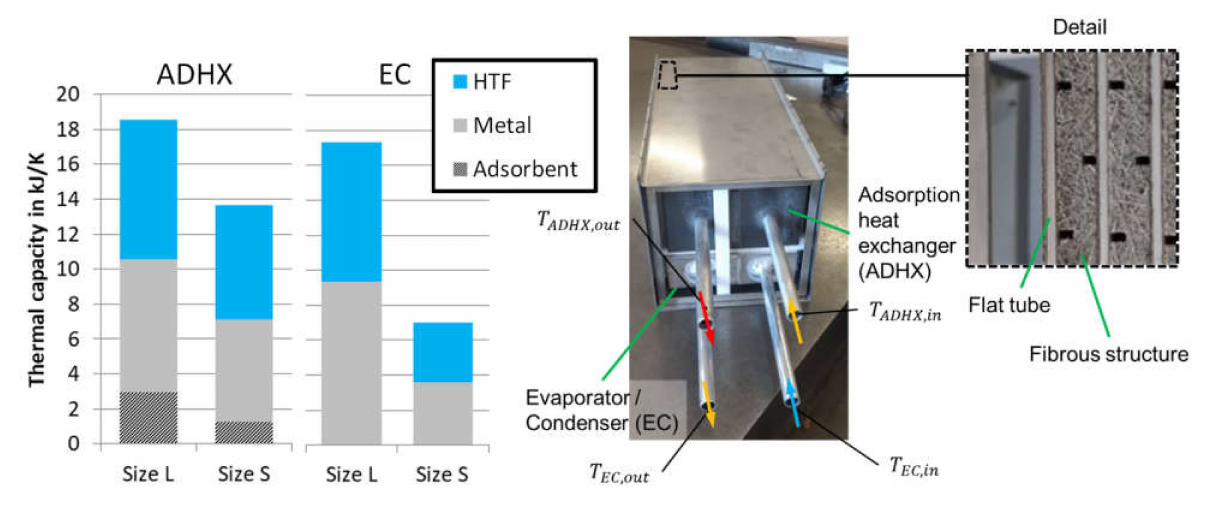
Figure 1. Thermal capacities of the sorption modules ( left ), picture of the module ‘Size S’ ( middle ) [30], detail of the fiber heat exchanger ( right )